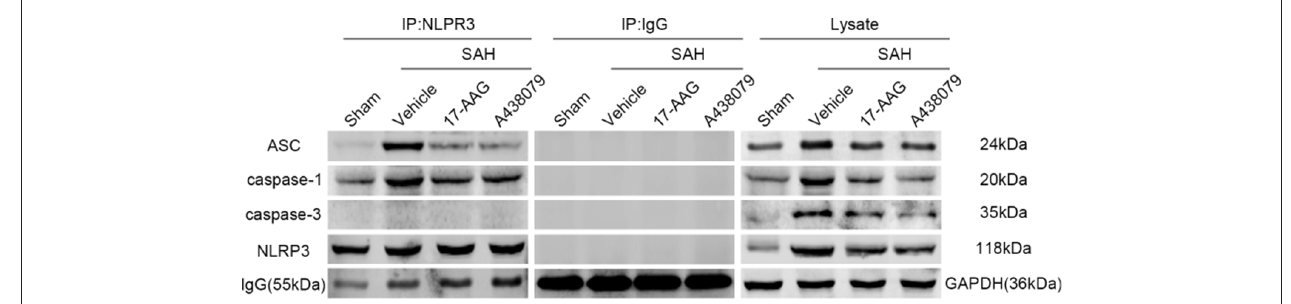
FIGURE 10 | Effects of 17-AAG and A438079 on the SAH-induced NLRP3 inflammasome resemble. Immunoprecipitation (IP) assay of NLRP3: ASC, NLRP3: caspase-1 and NLRP3: caspase-3 in left hemisphere after SAH.